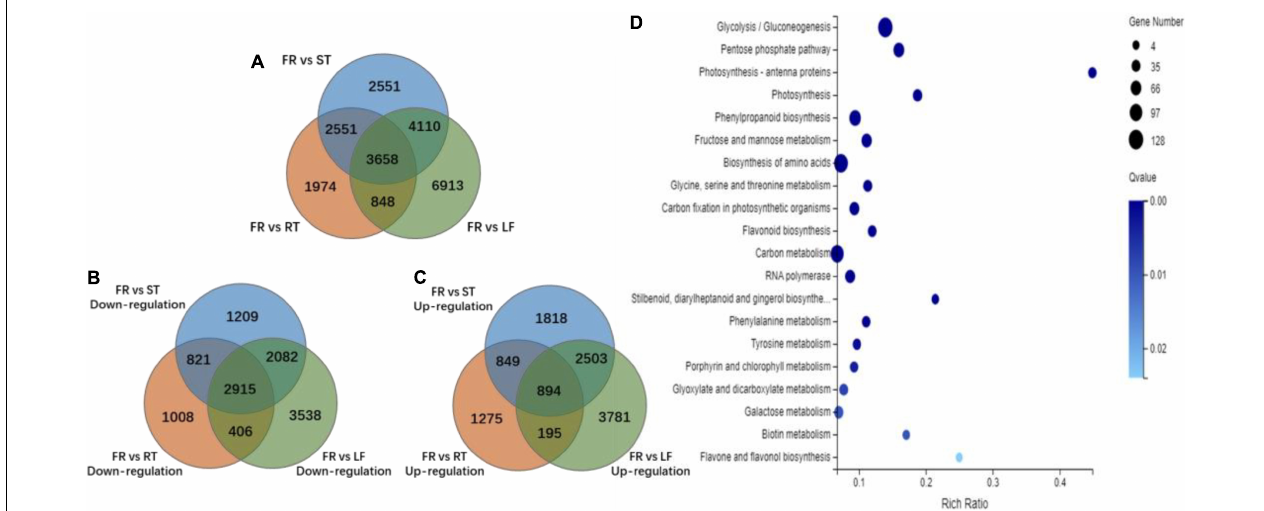
FIGURE 3 | Identification of specific unigenes in FR of Trapa bispinosa by DEGs analysis. (A) The Venn diagram of identified DEGs in each group. (B) The Venn diagram of DEGs that were only up-regulated in FR. (C) The Venn diagram of DEGs that were only down-regulated in FR. (D) Statistical analysis of KEGG pathway enrichment for DEGs that were only up-regulated in